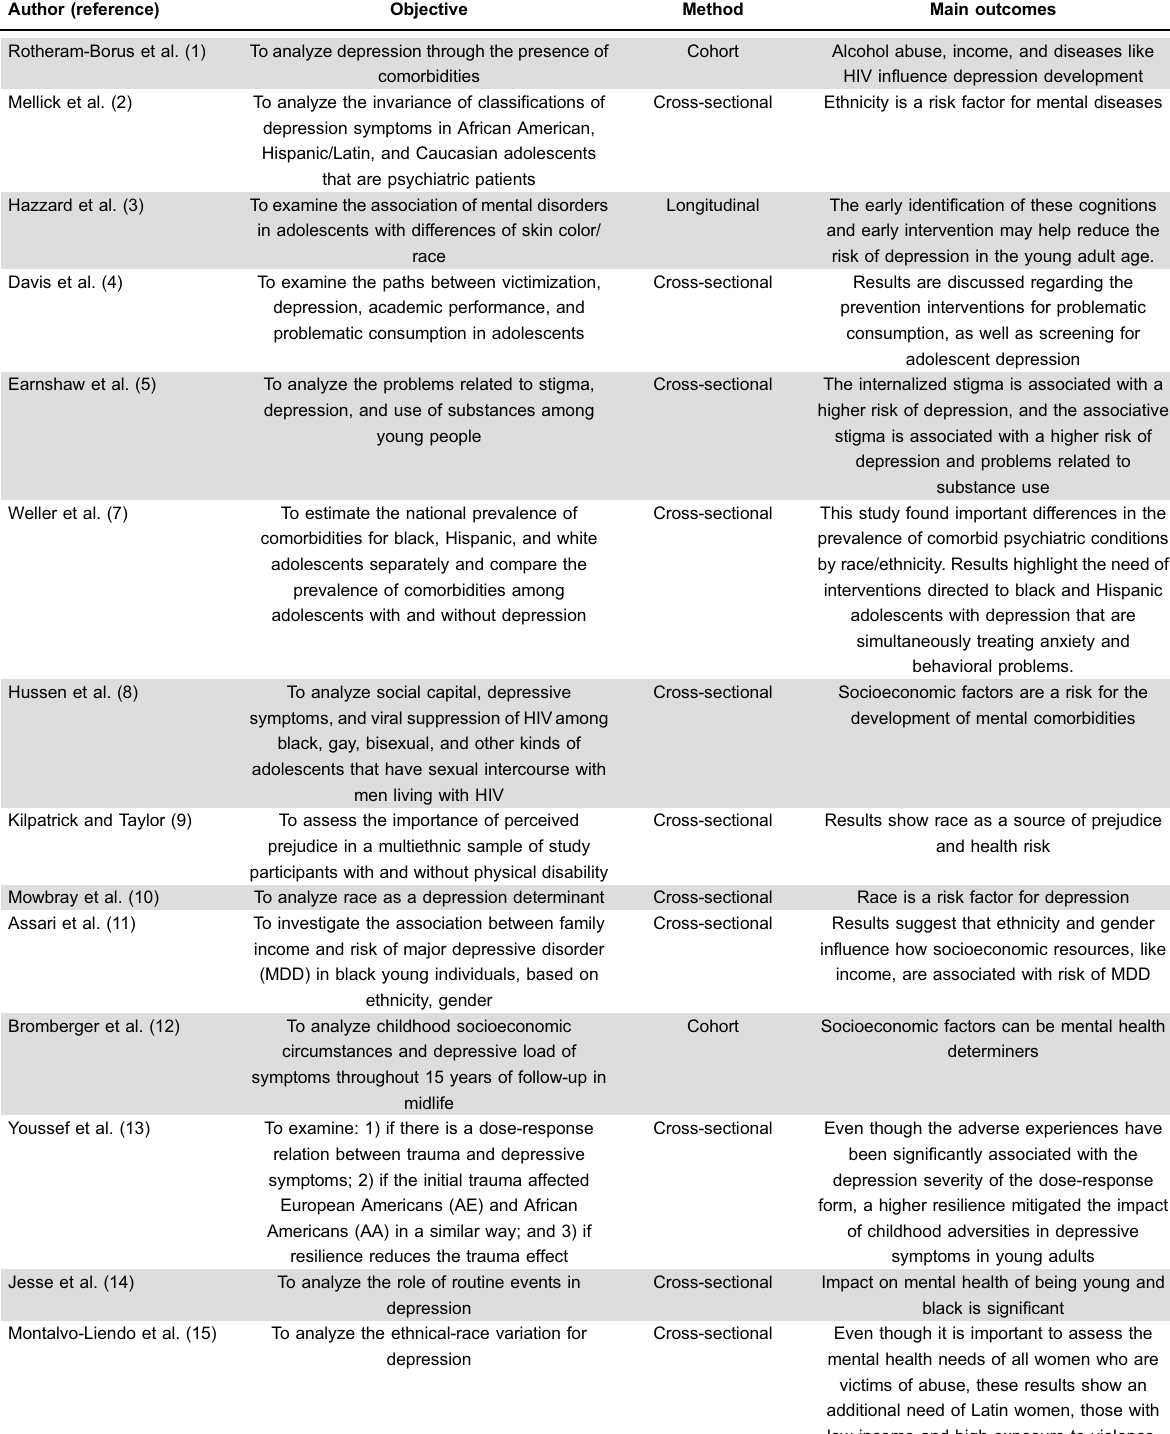
Table 1. Synthesis of the selected